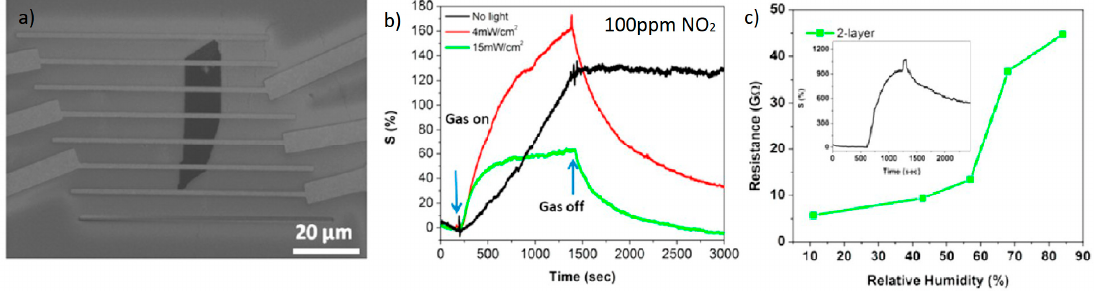
Figure 9. ( a ) SEM image of two-layer MoS 2 transistor device; ( b ) Sensing behavior of five-layer MoS 2 exposed to 100 ppm NO 2 under green light illumination; ( c ) Resistance as a function of RH for two-layer MoS 2 samples. Reprinted (adapted) with permission from [61]. Copyright (2013) American Chemical Society: Washington, DC,